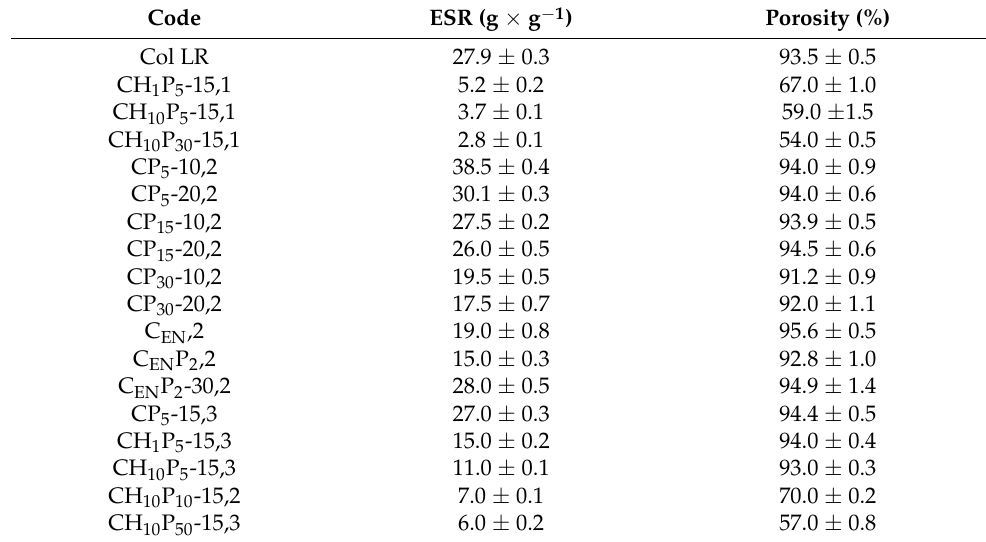
Table 1. Investigated collagen-based matrices. Composition and certain